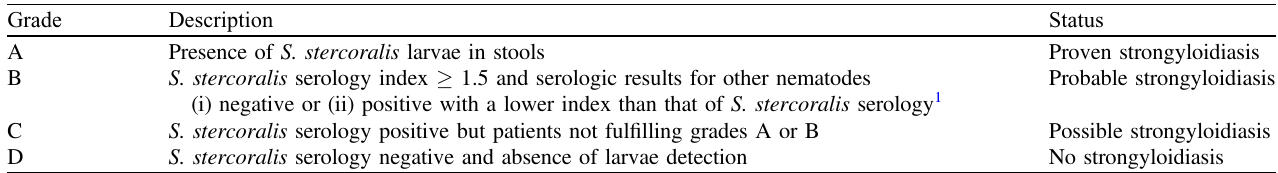
Table 1. Criteria used for the classi fi cation of